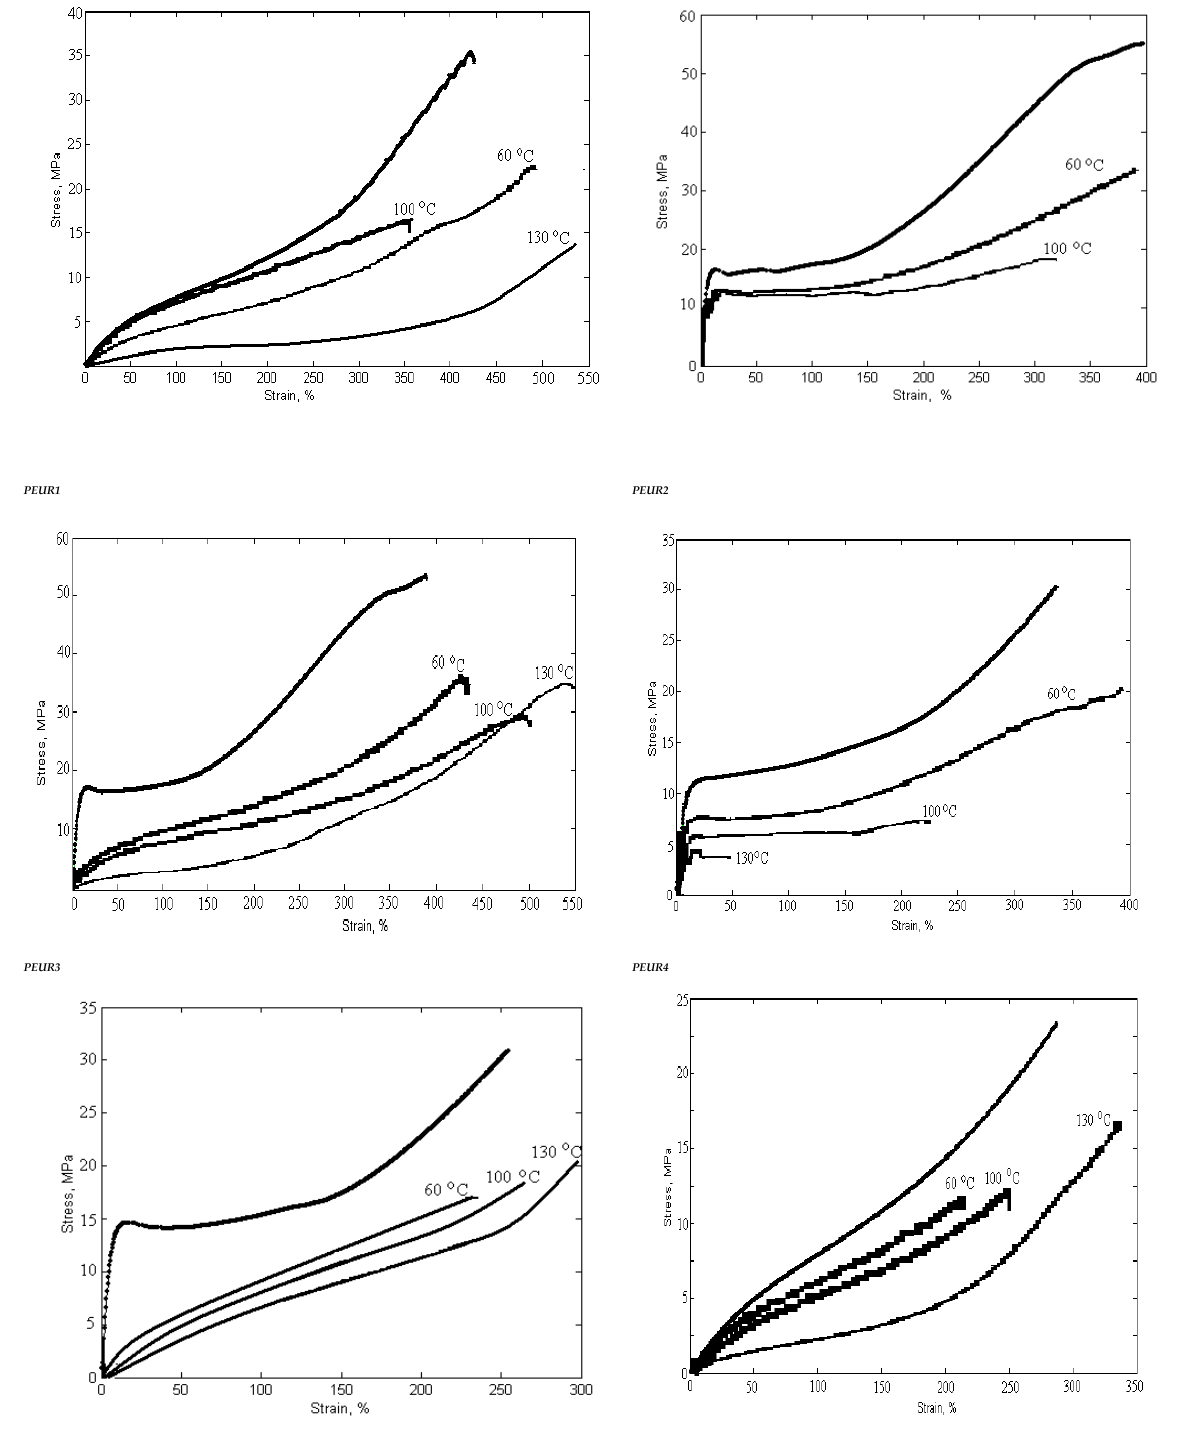
Figure 11. Variation of physico-mechanical properties with temperature and heating time.